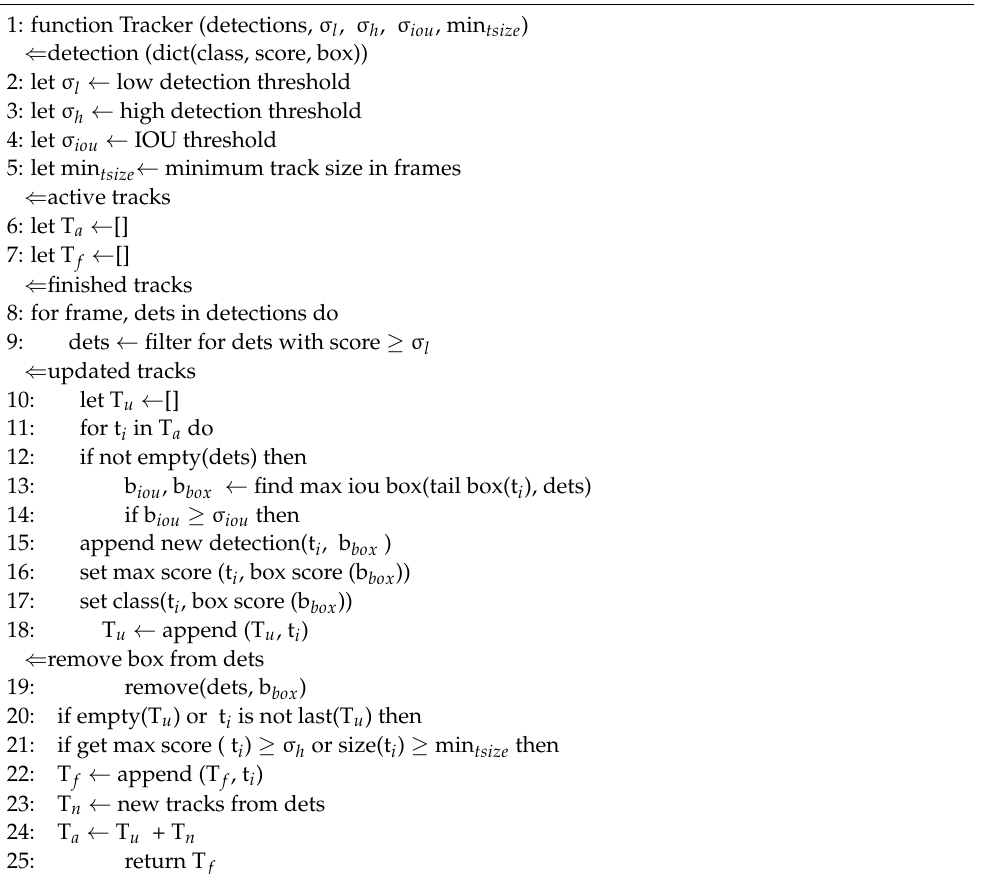
Algorithm 1: IOU Tracking